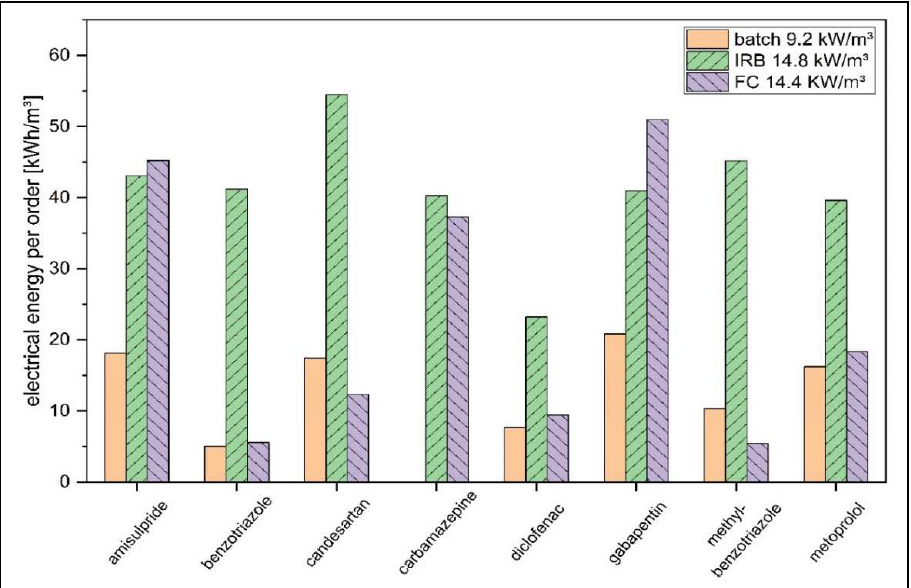
Figure 8. Calculated EE/O value for the photocatalytic oxidation of all micro-pollutants within all three reactor systems at a radiation power of 9.2–14.8 kW/m³.